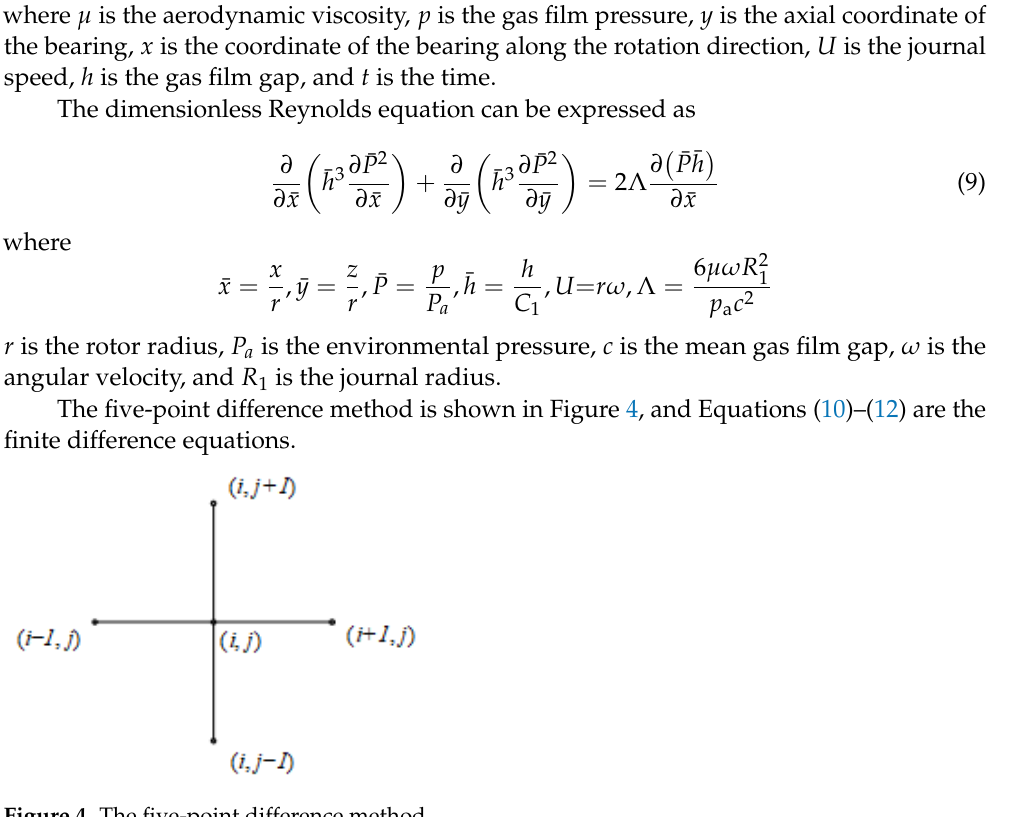
Figure 4. The five-point difference